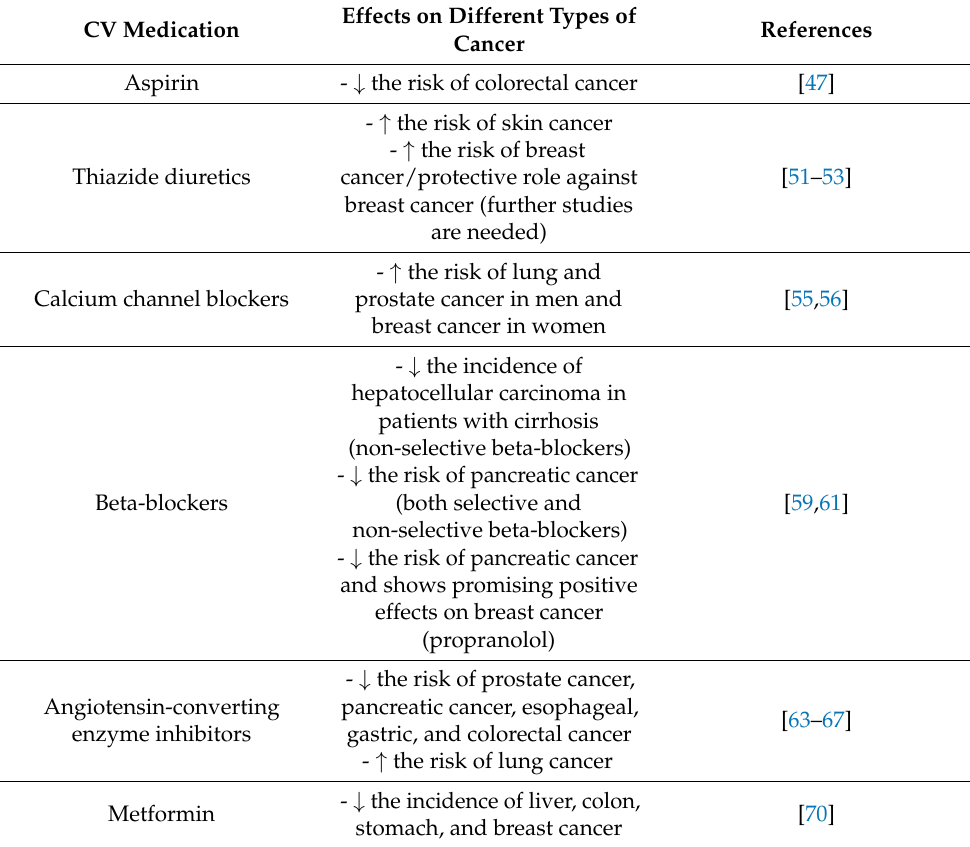
Table 1. Effects of CV medication on different types of cancer. Effects on Different Types CV Medication